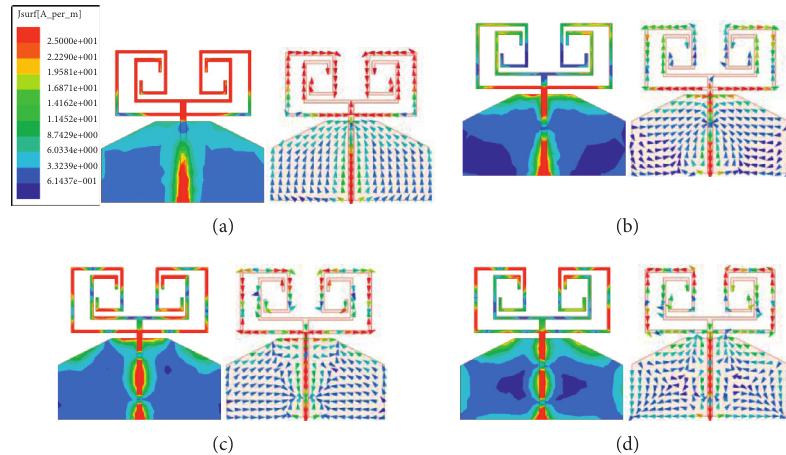
Figure 6: Surface current and vector diagram: (a) 1.55GHz, (b) 2.4 GHz, (c) 5.05GHz, and (d) 5.84 GHz.